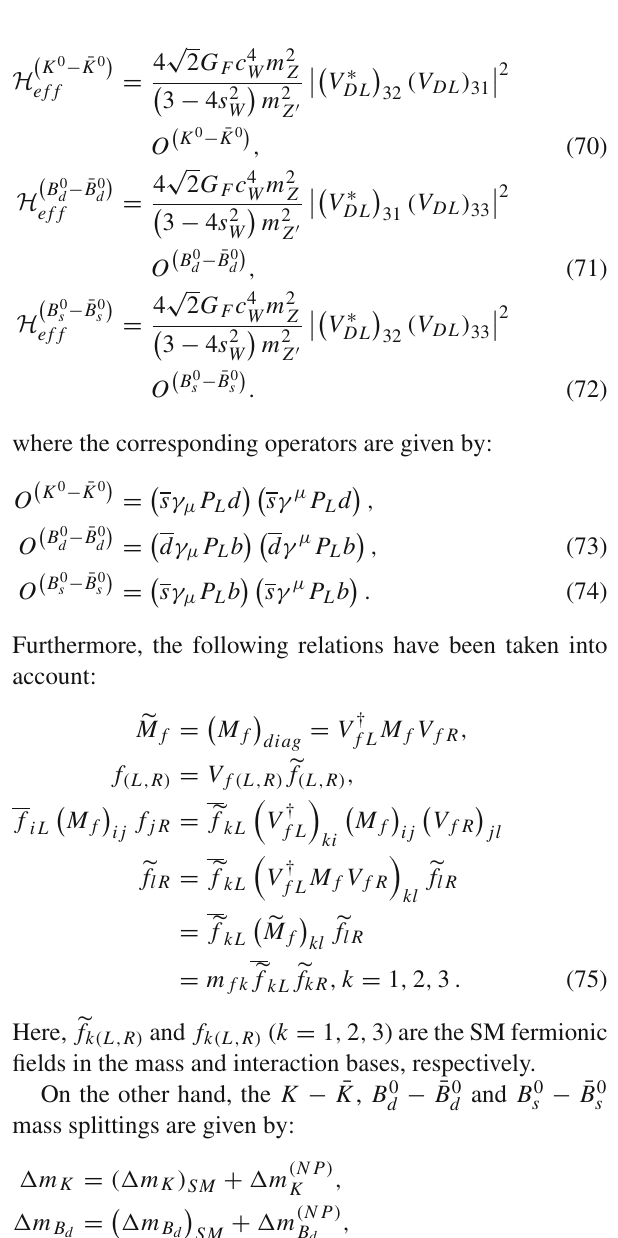
Fig. 6 Feynman diagrams corresponding to Beyond Standard Model contributions to the muon anomalous magnetic moment in the 3-3-1 model under consideration. Notice that the second diagram involving